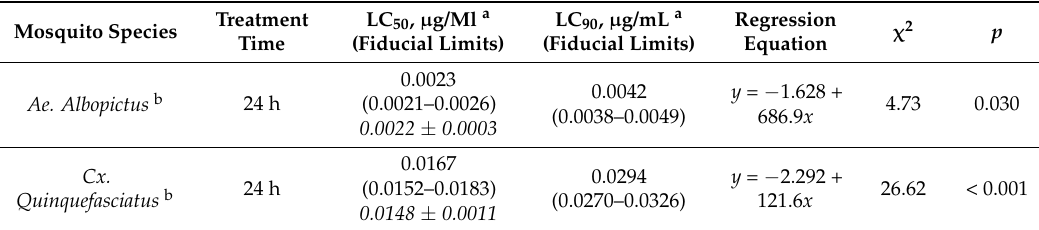
Table 6. Mosquito larvicidal activity of permethrin (positive control).